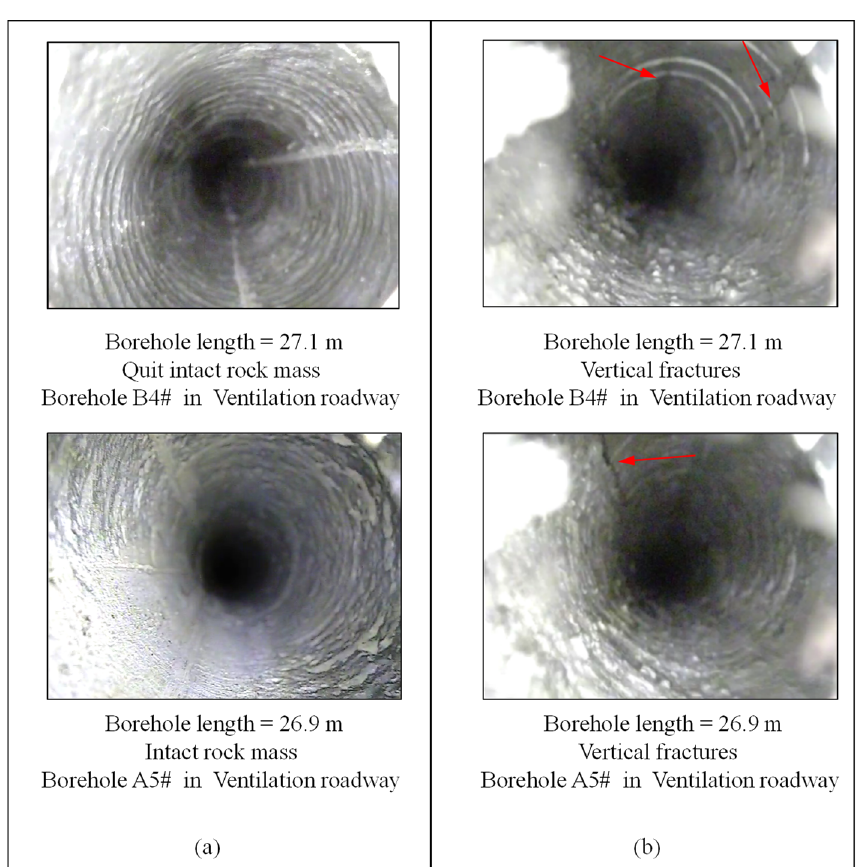
Figure 8. Comparison of fracture development before and after hydraulic fracturing: ( a ) before hydraulic fracturing; ( b ) after hydraulic fracturing.